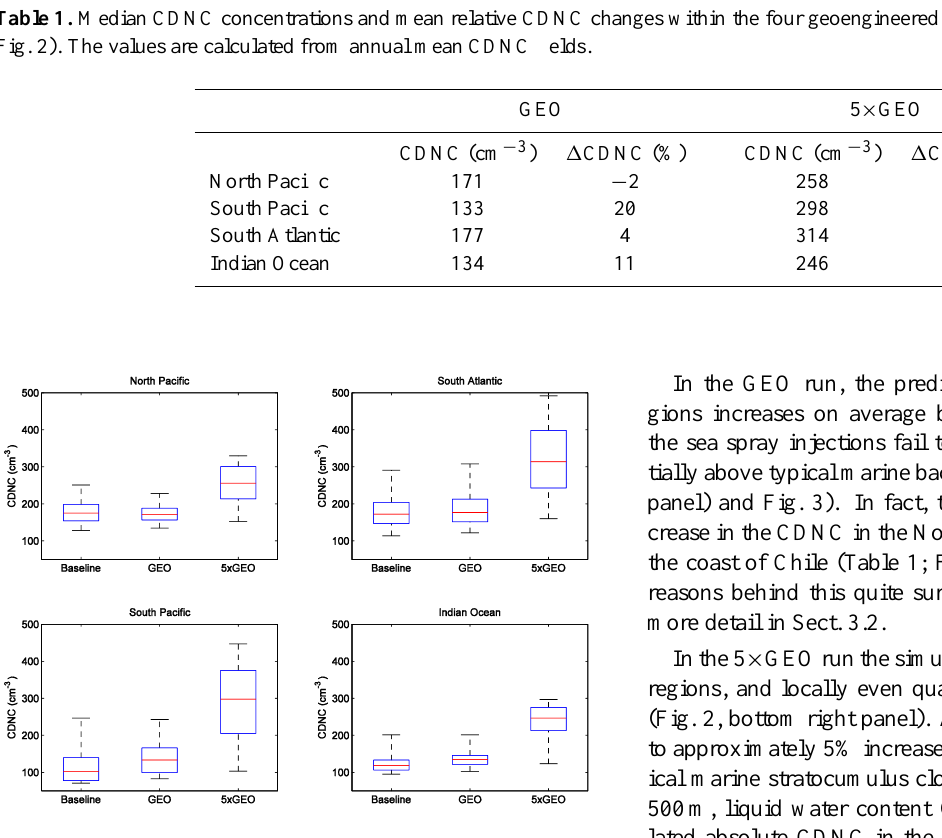
Fig. 3. The range of predicted annual mean CDNC within the four Figure 3: The range of predicted annual mean CDNC within the four seeded regions at 1 km seeded regions at 1km altitude. The red line indicates the median, altitude. The red line indicates the median, the blue box the 25 th and 75 th percentiles, and the the blue box the 25th and 75th percentiles, and the black whiskers black whiskers the 5 th and 95 th percentiles. The number of model grid boxes in the North the 5th and 95th percentiles. The number of model grid boxes in the Pacific is 107, in the South Atlantic 131, in the South Pacific 256, and in the Indian Ocean North Pacific is 107, in the South Atlantic 131, in the South Pacific 217. 256, and in the Indian Ocean